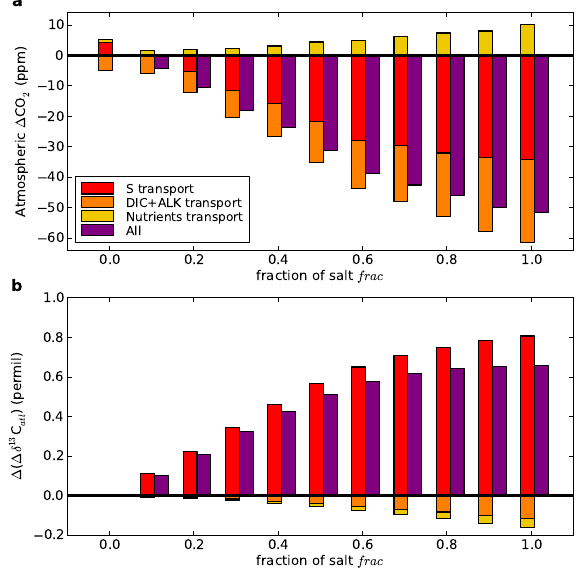
Fig. 3. (a) Atmospheric CO 2 change ( 1 CO 2 ) and (b) 1δ 13 C atl change ( 1 ( 1δ 13 C atl )) due to the transport of salt (S), dissolved in- change ( ∆ CO ) and (b) ∆ δ 13 C change ( ∆ ( ∆ δ 13 C )) due to Fig. 3. (a) Atmospheric CO 2 2 atl atl organic carbon (DIC) and alkalinity (ALK), nutrients, and dissolved the transport of salt (S), dissolved inorganic carbon (DIC) and alkalinity (ALK), nutrients, and organic carbon (DOC, too small too be visible, less than 1ppm). In dissolved organic carbon (DOC, too small too be visible, less than 1 ppm). In all simulations all simulations the transport of salt is activated. In the “S transport” the transport of salt is activated. In the “S transport” experiment only salt is transported, in experiment only salt is transported, in “DIC+ALK transport” salt, DIC and ALK are transported, in “Nutrients transport” salt and nu- “DIC+ALK transport” salt, DIC and ALK are transported, in “Nutrients transport” salt and nutri- Fig. 2. (a) Atmospheric CO 2 concentration, (b) 1δ 13 C atl (mean trients are transported. “All” is the effect of the simultaneous trans- ents are transported. “All” is the effect of the simultaneous transport of all variables. ∆ CO is upper (-2000m to 0m) to deep ( − 5000m to − 3000m) gradient in 2 port of all variables. 1 CO 2 is the difference between the modeled CO concentration, (b) ∆ δ 13 C (mean upper (-2000 m to 0 m) to Fig. 2. (a) Atmospheric the difference between the modeled CO and the standard modeled CO (LGM std, CO =296 2 atl the Atlantic) and (c) salinity in the deep Southern ocean (Atlantic 2 2 2 CO 2 and the standard modeled CO 2 (LGM std, CO 2 =296ppm). deep (-5000 m to -3000 m) gradient in the Atlantic) and (c) salinity in the deep Southern ocean sector, 50 degrees South, 3626m depth) as a function of the frac- ppm). ∆ ( ∆ δ 13 C ) is the difference between the modeled ∆ δ 13 C and the standard modeled 1 ( 1δ 13 C atl ) is the difference between the modeled 1δ 13 C atl and atl atl tion of salt released by sea ice formation used for the brine mecha- (Atlantic sector, 50 degrees South, 3626 m depth) as a function of the fraction of salt released ∆ δ 13 C (LGM std). the standard modeled 1δ 13 C atl (LGM atl nism (fraction of salt frac , 0 ≤ frac ≤ 1). frac = 0 corresponds to the by sea ice formation used for the brine mechanism (fraction of salt frac , 0 ≤ frac ≤ 1 ). frac = standard simulations without any brine mechanism (all the salt and 0 corresponds to the standard simulations without any brine mechanism (all the salt and ions ions are diluted in the surface cell where sea ice is formed). When 27 are diluted in the surface cell where sea ice is formed). When frac = 1 all the released salt frac = 1 all the released salt and other ions sink with the brine mech- anism down to the abyss. The Last Glacial Maximum (LGM) and and other ions sink with the brine mechanism down to the abyss. The Last Glacial Maximum 26 Pre-industrial (PI) data are from Monnin et al., 2001; Curry and (LGM) and Pre-industrial (PI) data are from Monnin et al., 2001; Curry and Oppo, 2005; K¨ohler Oppo, 2005; K¨ohler and Bintanja, 2008; Adkins et al., 2002. and Bintanja, 2008; Adkins et al., 2002.